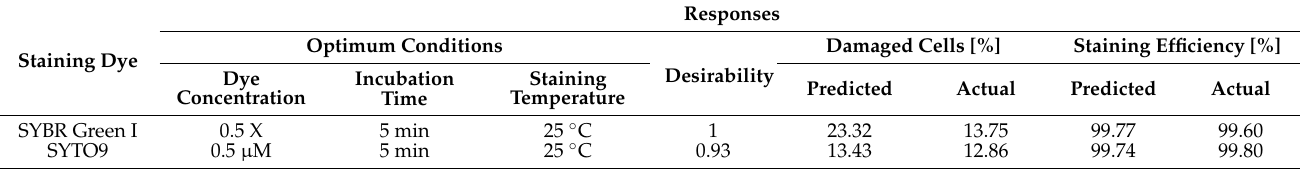
Table 5. Predicted and experimentally determined number of responses under optimized variable conditions (n =